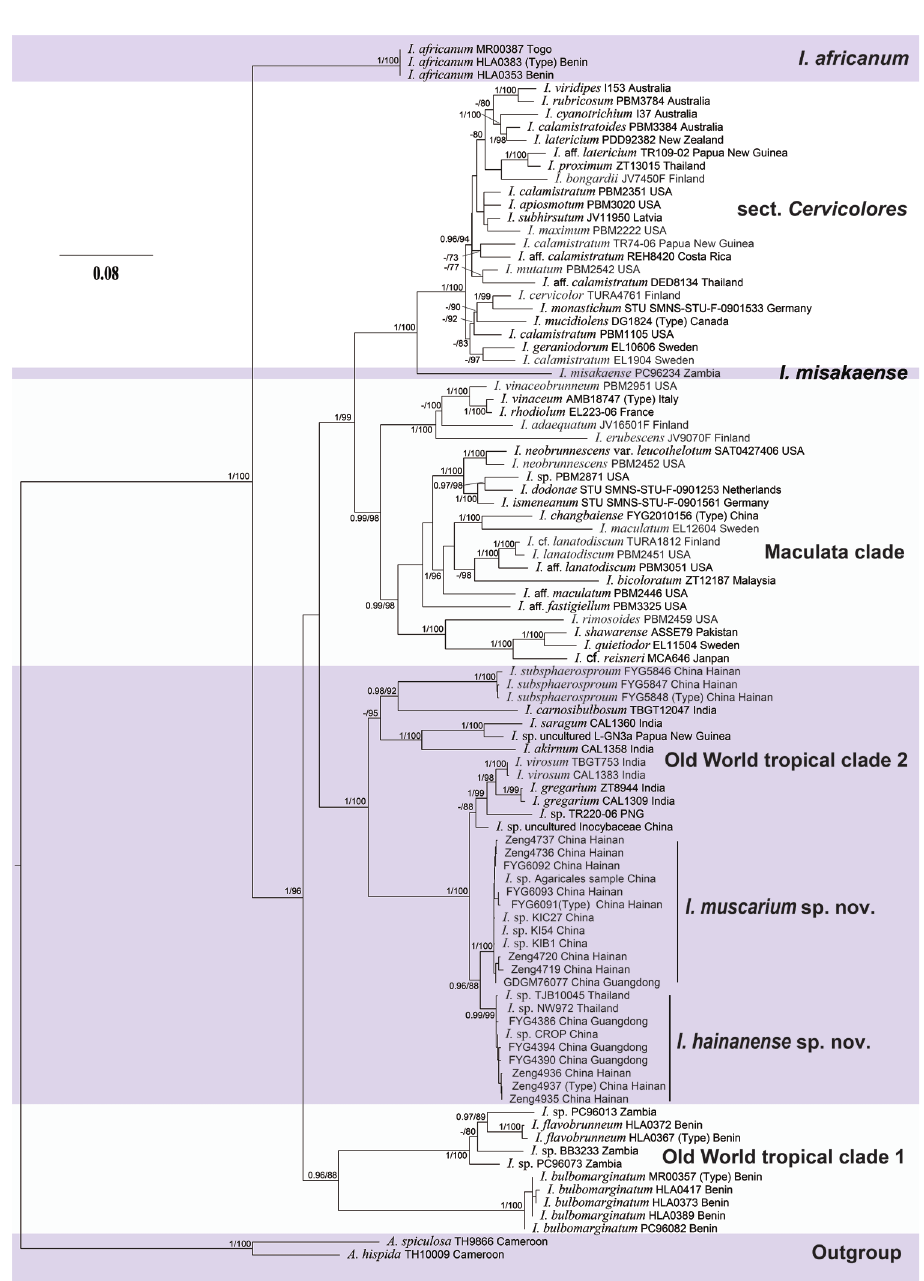
Figure 1. Phylogram generated by Bayesian Inference (BI) analyses based on sequences of a combined data set from nuclear genes (rDNA-ITS, nrLSU, and rpb2 ), rooted with Auritella hispida and A. spiculosa. Bayesian Inference posterior probabilities (BI-PP) ≥0.95 and ML bootstrap proportions (ML-BP) ≥70 are represented as BI-PP/ML-BP. I. muscarium sp. nov. and I. hainanense sp. nov. are two newly described